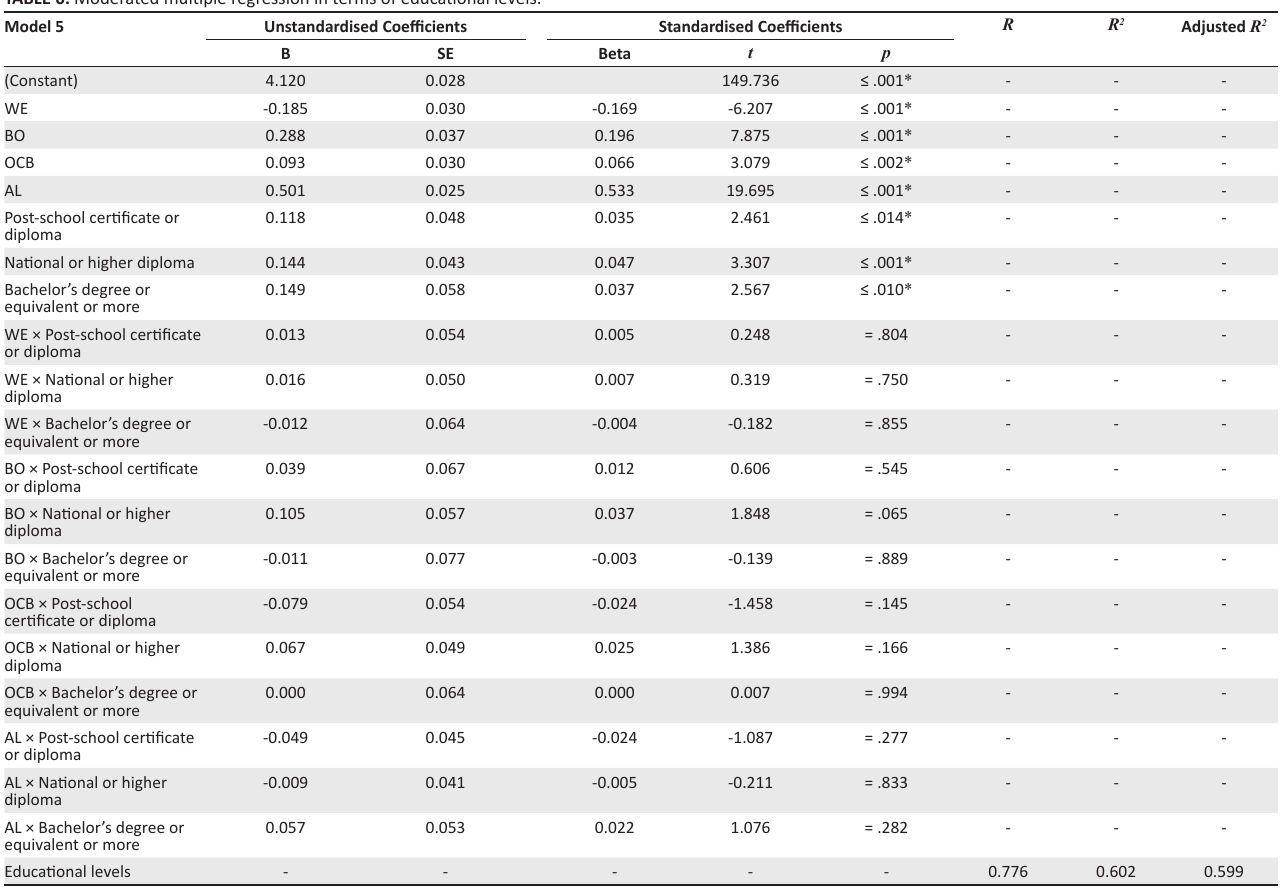
TABLE 6: Moderated multiple regression in terms of educational